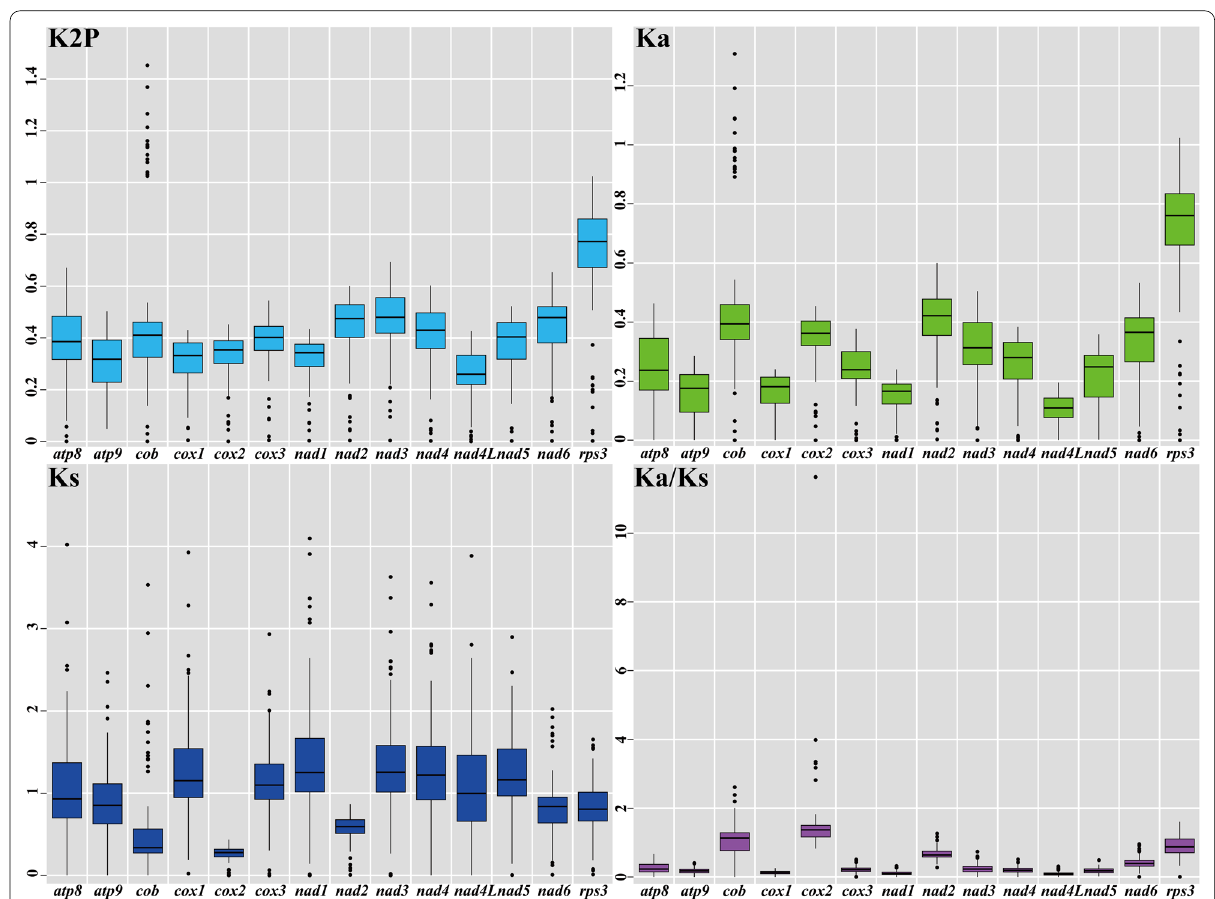
Fig. 4 Genetic analysis of 15 protein coding genes conserved in 17mitogenomesfrom Agaricomycotina , Pucciniomycotina and Ustilaginomycotina . K2P, the Kimura-2-parameter distance; Ka , the number of nonsynonymous substitutions per nonsynonymous site; Ks , the number of synonymous substitutions per synonymous